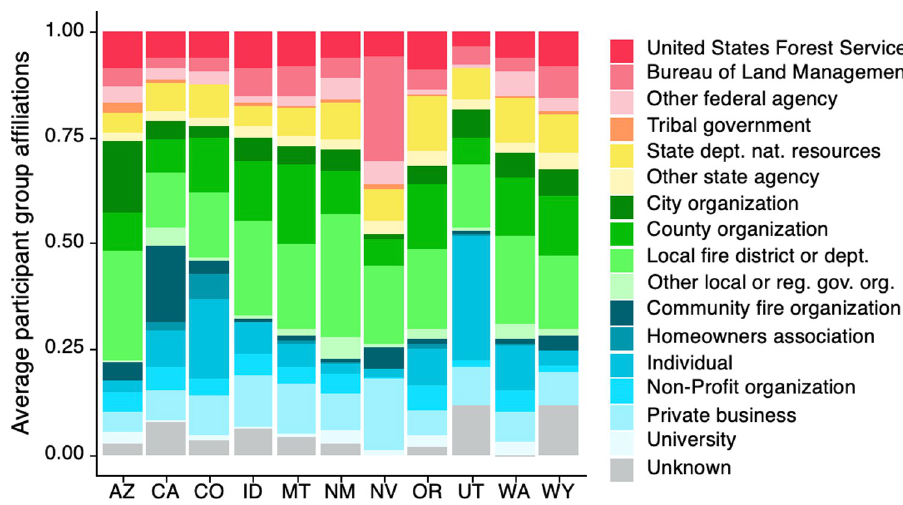
Fig 5. The average proportion of organizational diversity from CWPP participants by state. Color hues indicate high-level groupings of affiliation categories: red/orange, federal and tribal governmental agencies; yellow, state governmental agencies; green, local governmental agencies; blue, non-governmental organizations; grey, unknown.